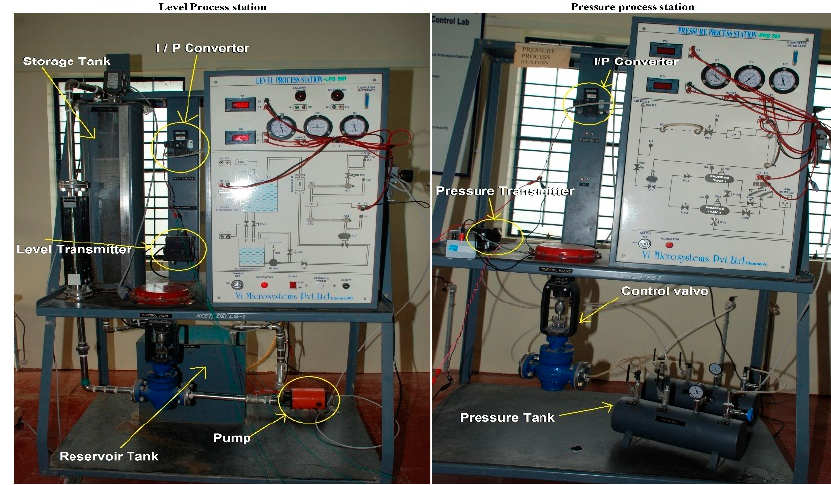
Figure 7. Level process station.